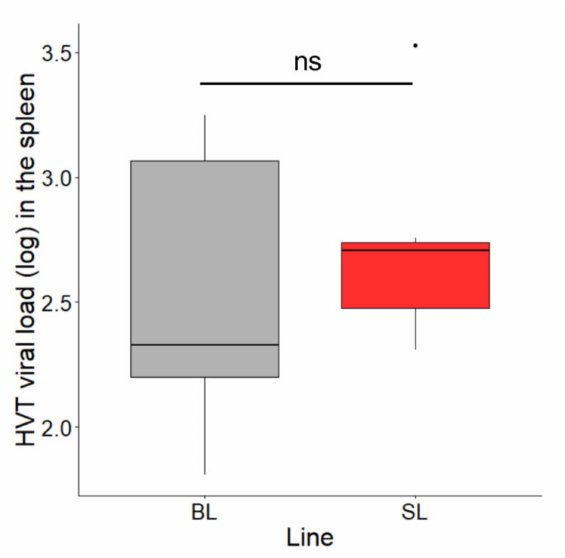
Figure 5. HVT loads in the spleen at 15.5 months of age in SL and BL chickens. Seven birds of each line were analyzed. The HVT load unit is HVT genome copy number per million cells. Data are shown in Tukey boxes with the medians visible as thick horizontal bars (212 for BL, 507 for SL). The di ff erence in HVT load in the spleen was not significant between the two lines (exact p -value = 0.7995; permutation test for two independent groups). ns,